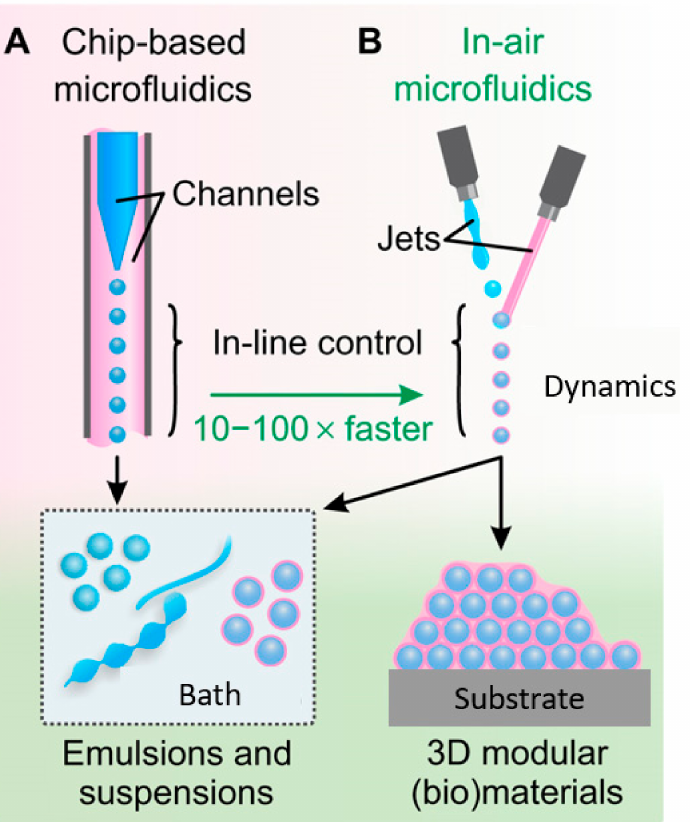
Figure 31. IAMF concept. ( A ) A chip design where droplets (blue) are transported by a coflow (pink). ( B ) IAMF relying on jet ejection and coalescence into air. When combining reactive, solidifying microjets, IAMF also enables on-the-fly production and direct deposition of microparticles into 3D multiscale modular (bio)materials. Reprinted from an open-access source